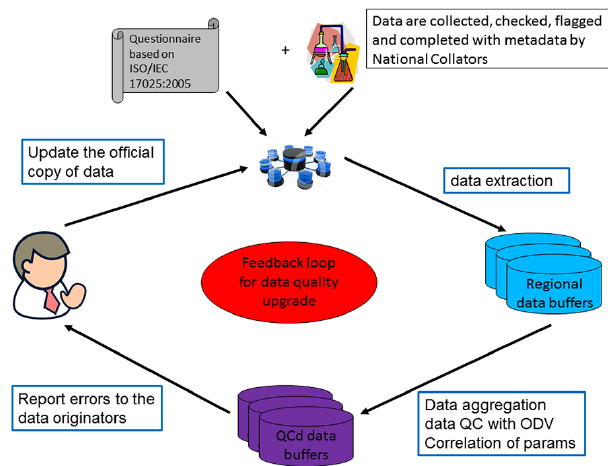
Figure 5. Data validation